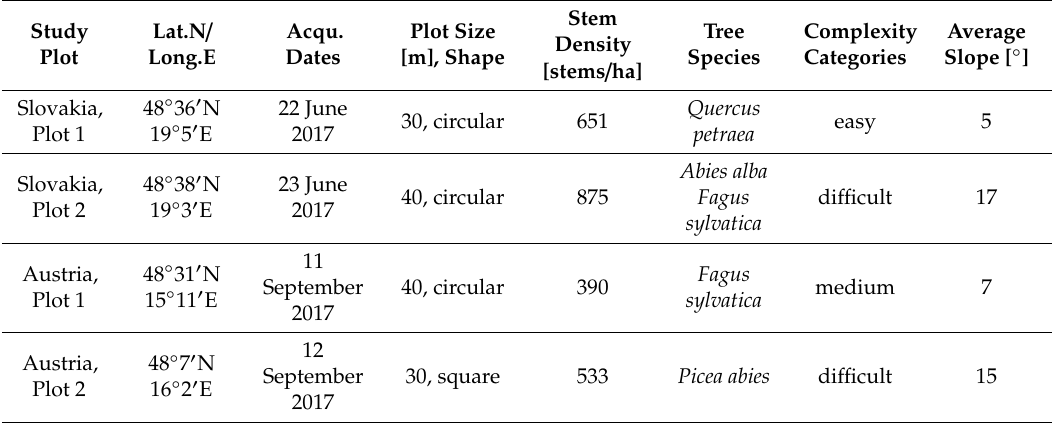
Table 1. Acquisition dates and characteristics of each